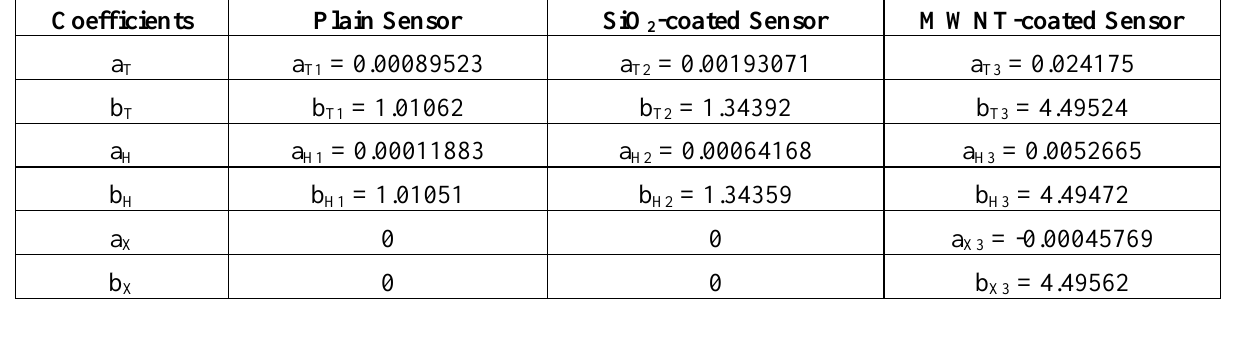
coated, and MWNT-SiO 2 -coated 2